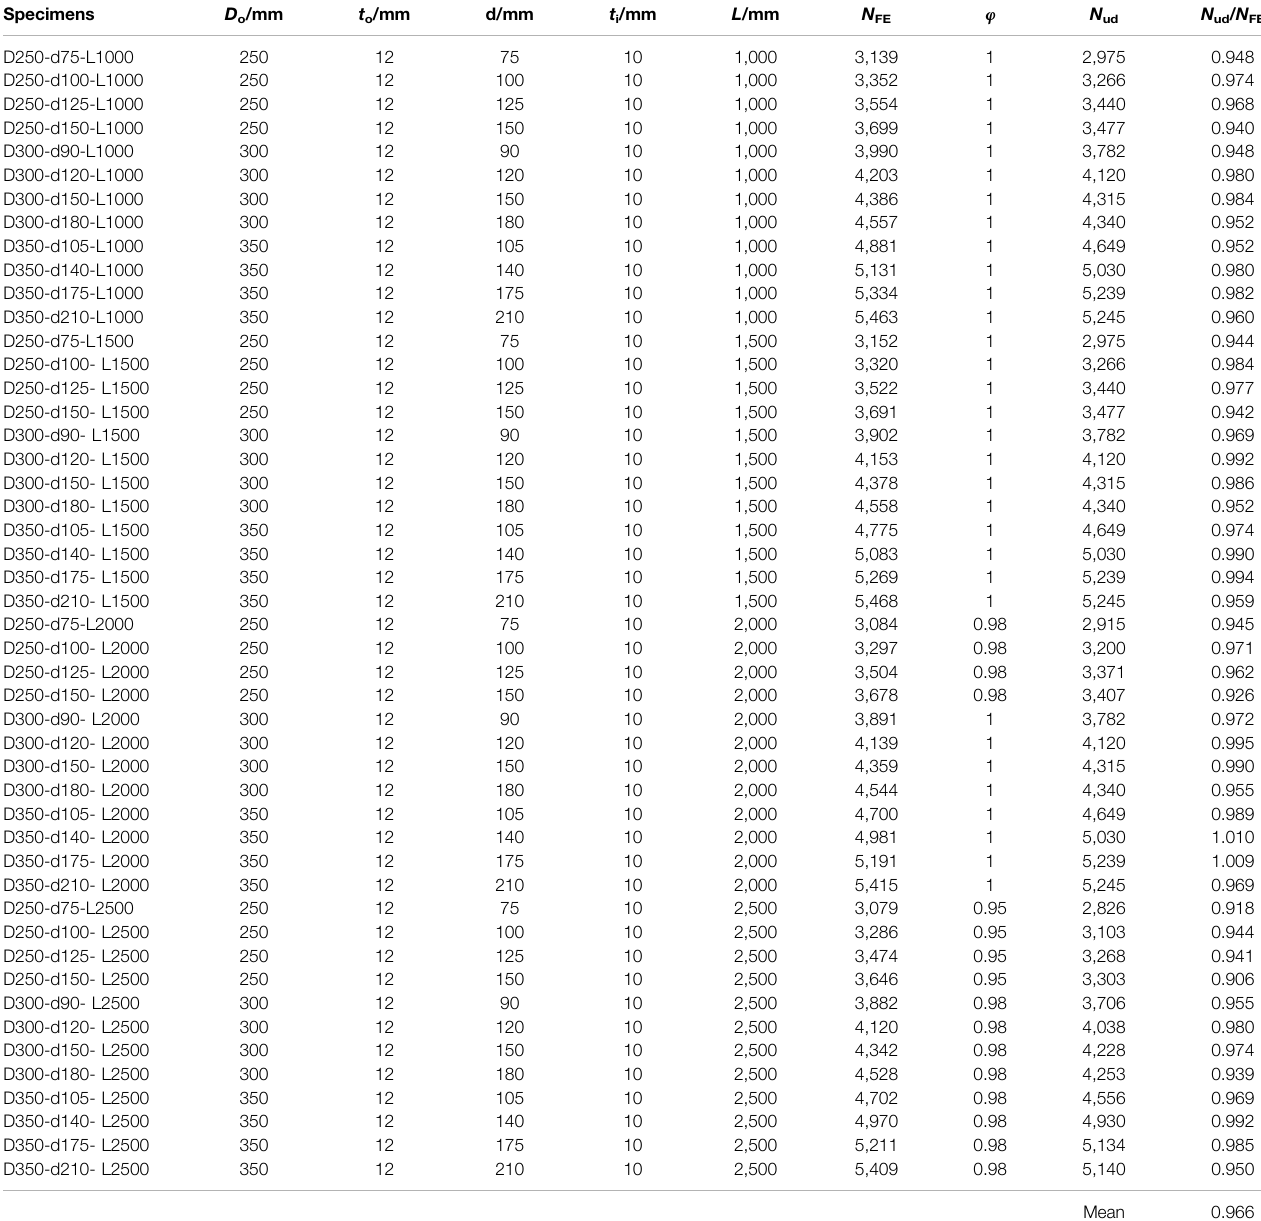
TABLE 6 | Comparison between the calculated results and FE results.